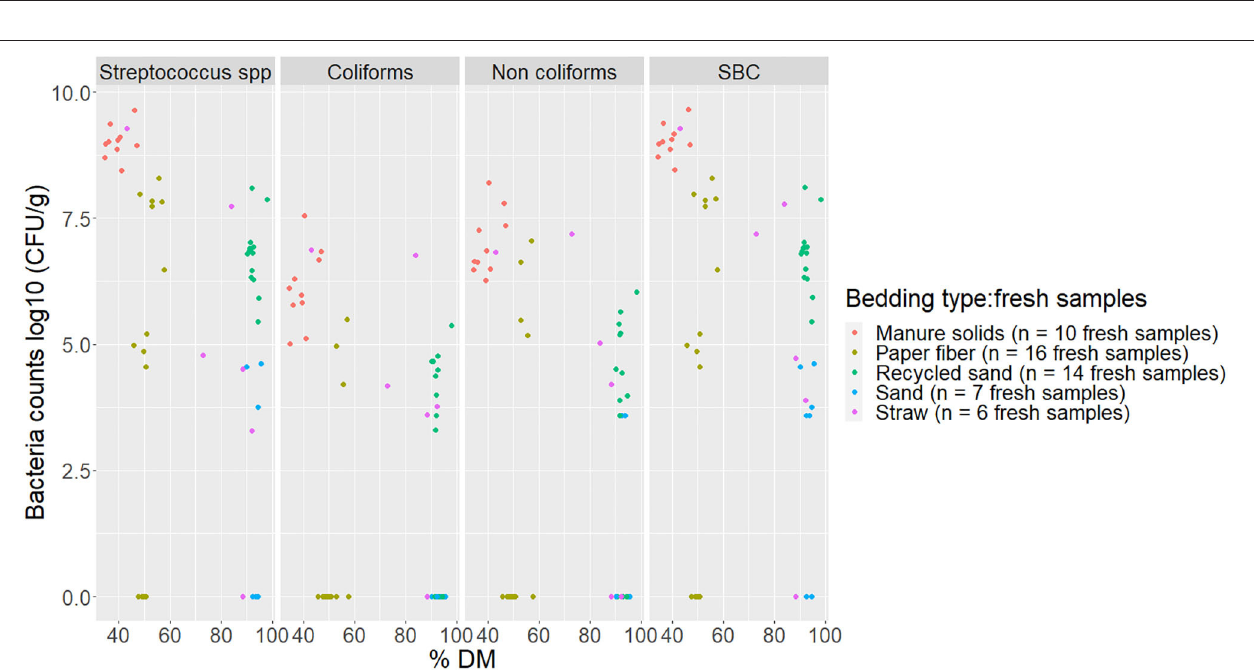
FIGURE 5 | Scatterplot of DM content (% DM) vs. bacteria counts (log10 CFU/g) by bacteria group from fresh samples collected from July 2018 to July 2019 from five conveniently selected New York dairy herds using one of five bedding materials in lactating pens. One fresh bedding sample was collected monthly following an SOP at each visit (unless there was no bedding available due to lack of supply or equipment malfunction on the follow-up visit). When no bacteria were identified, a value of log 10 + 1 CFU/g was given, assuming that at least 10 CFU were present. SBC (sum bacterial count) = Streptococcus spp, coliforms and non-coliforms summed.